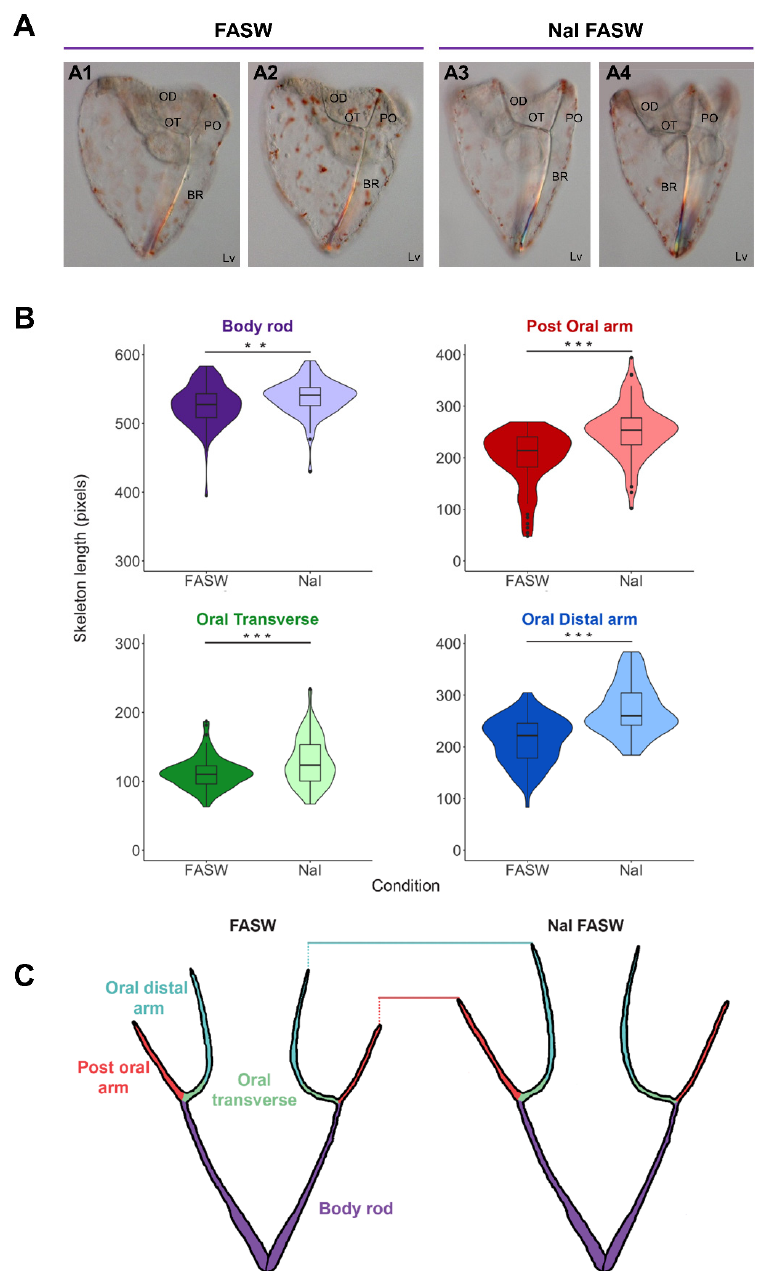
Figure 2. Iodide accelerates skeleton growth in sea urchin larvae. ( A ) The phenotype of 4 dpf S. purpuratus pluteus larvae cultured in filtered artificial seawater ( A1 , A2 ) and sodium iodide (NaI) in FASW ( A3 , A4 ), respectively. ( A1 , A2 ) and ( A3 , A4 ) are different focal planes of the same larvae focusing on the right and left arms, respectively. ( B ) Four violin plots with box and whisker plots overlaid plotting the length of the skeleton (pixels) for the different skeletal parts in FASW ( n = 42) (negative control) and sodium iodide (NaI) in FASW ( n = 43), measured in larvae collected from three independent experiments. Boxes show the median, lower and upper quartiles, while the whiskers extend to the minimum and maximum data points. A student’s two-tailed t-test was performed, ** ( p < 0.01) and *** ( p < 0.001), and reveals that larval skeletal parts are significantly longer when cultured in NaI FASW, with the post-oral, oral transverse, and oral distal skeletal lengths the longest and body rod a little longer. ( C ) Cartoon skeletons illustrating the longer skeletal lengths in the NaI FASW condition compared to normal FASW. BR, Body Rod; OD, Oral Distal; OT; Oral Transverse; PO, Post Oral; Lv, lateral